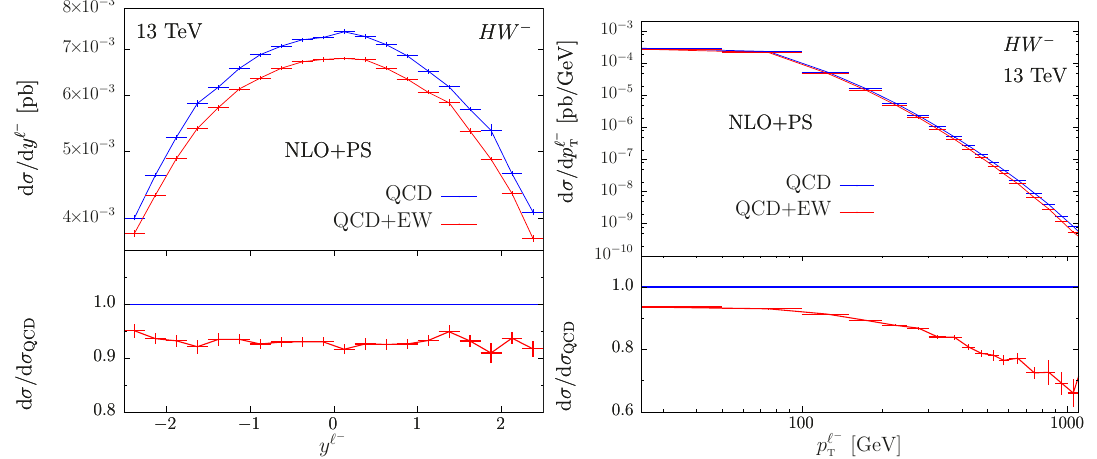
Figure 12. NLO+PS predictions for the distributions in the rapidity (left) and the transverse momentum (right) of the charged dressed lepton in HW (cid:0) production. Comparison between the full QCD+EW results and the QCD ones after the Pythia 8.1 QCD+QED